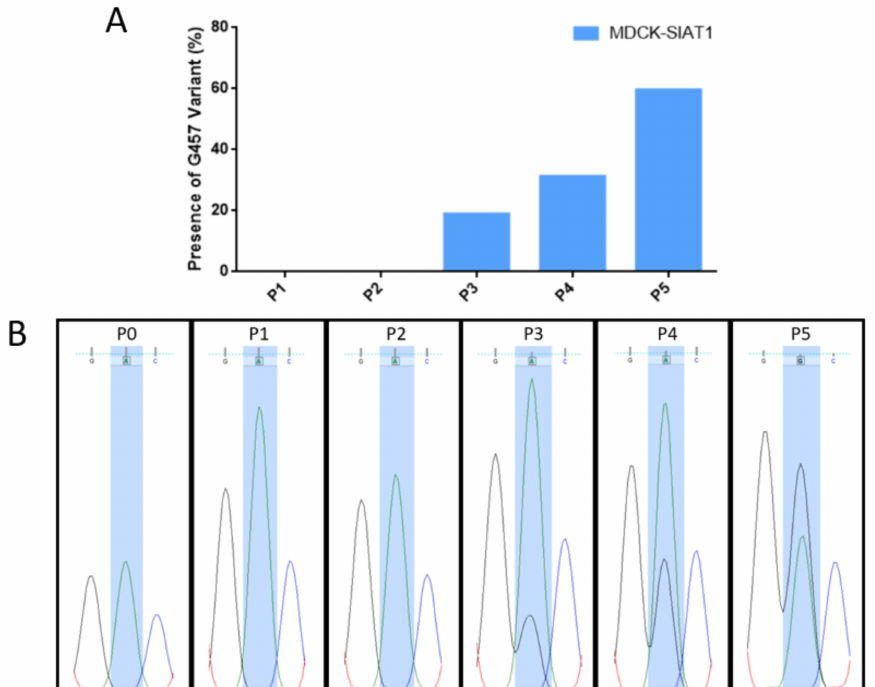
Figure 3. Presence or absence of the HA G457 variant (from the A1399G mutation) in different MDCK- SIAT1 passages. ( A ) Proportion of the height of the G nucleotide relative to the combined heights of both the G and A nucleotides. The height of each nucleotide peak was measured, and the proportion was expressed as a percentage. ( B ) Sequencing chromatograms for P0 and all MDCK-SIAT1 passages at nucleotide 1399. Chromatograms were visualized using FinchTV software.